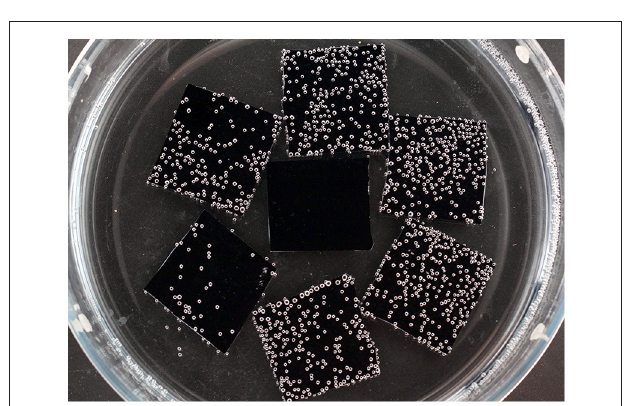
FIGURE 2 | Expansion of decompression bubbles on a hydrophobic surface. Six hydrophobic wafers on the periphery and one hydrophilic wafer in the center, photographed 2.5 h after decompression from 300 kPa (20m sea water) (taken from Arieli and Marmur, 2013a with permission).